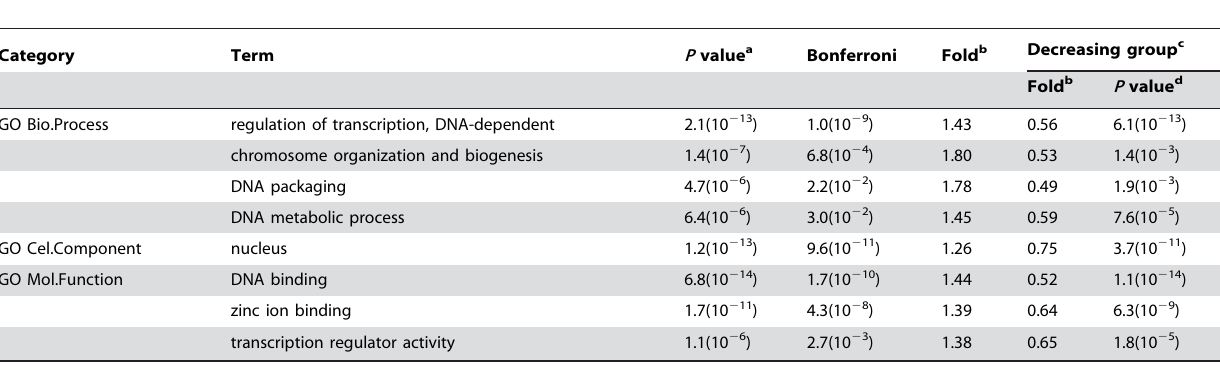
Table 4. Terms in the Gene Ontology and KEGG pathway databases over-represented among genes that increased expression with advancing age in the human brain (1,943 genes in total